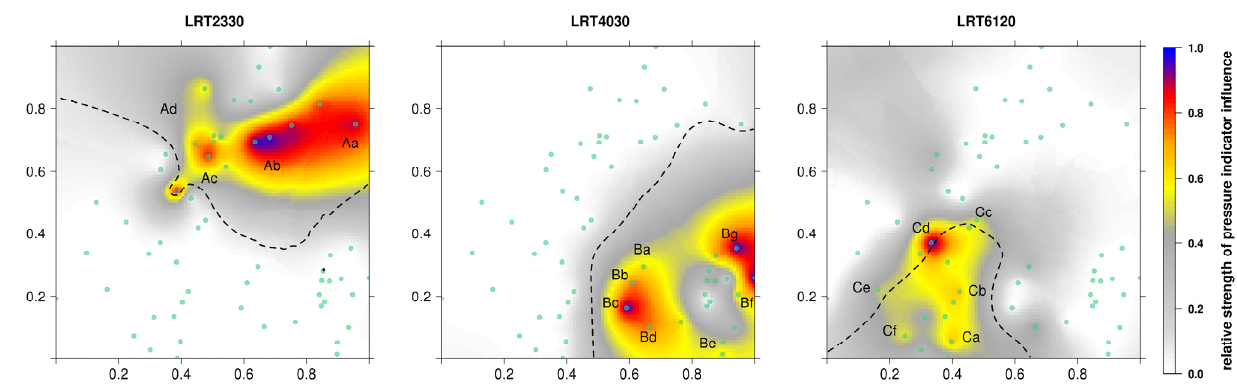
Figure 6. Kriging predictions for pressure strength on the basis of realized pressure functions. Letters correspond to pressure-factor complexes in Table 3, and dashed lines denote a habitat type probability of